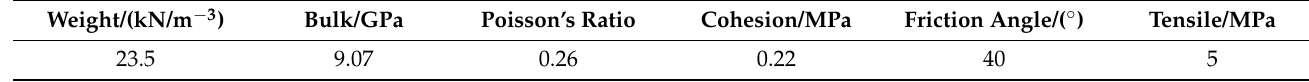
Table 2. Strength parameters of rock blocks.